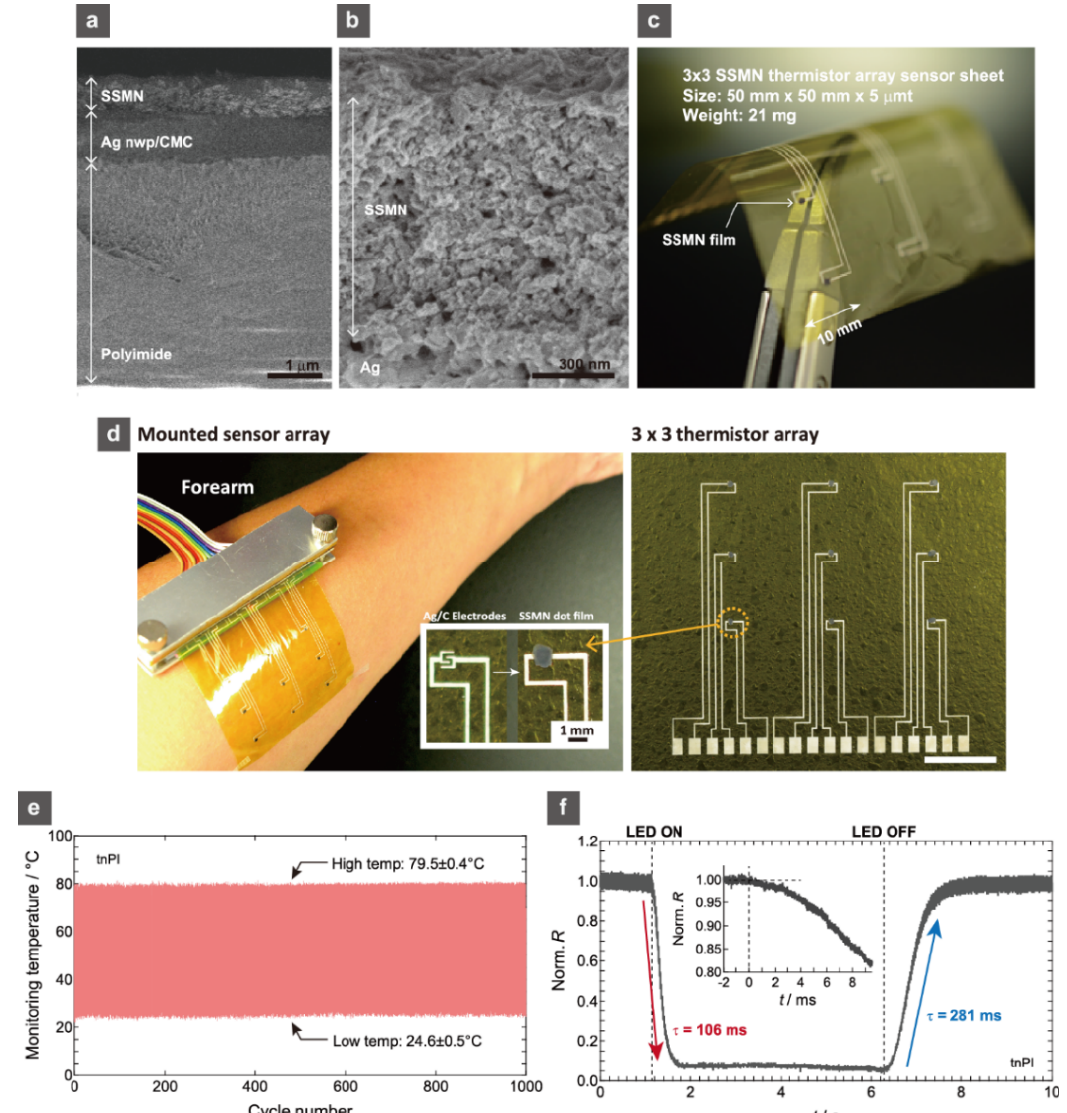
Figure 6. ( a ) FESEM image of the SSMN thermistor film on the thin PI substrate with the Ag nwp/CMC bottom electrode layer. ( b ) Enlarged FESEM image of the SSMN layer on the thin PI substrate. ( c ) Photographs of the 3 × 3 array patterns of the SSMN thermistor sub-millimeter sized (900 μm diameter) films on the 5 × 5 cm thin PI sheets with the Ag nwp/CMC bottom electrode patterns and ( d ) the mounted sensor array film on the human forearm. ( e ) Temperature cycling test for the SSMN thermistor film on thin PI for 0–1000 cycles. ( f ) Normalized R variation of the SSMN thermistor film on thin PI during UV LED illumination. Reprinted with permission from Ref. [53].